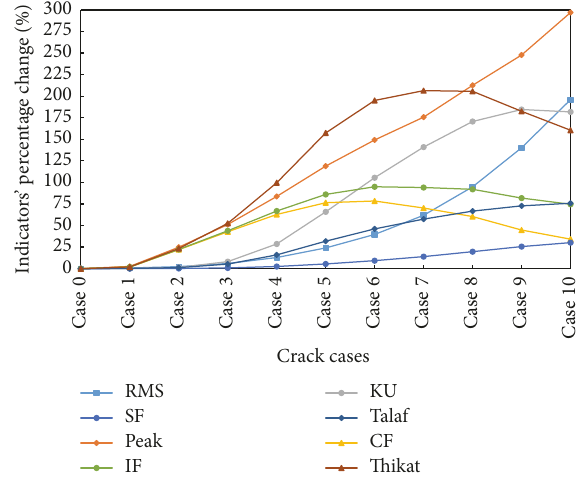
Figure 32: Performance of different time domain indicators applied to the residual signal for the fourth multiple-crack scenario.